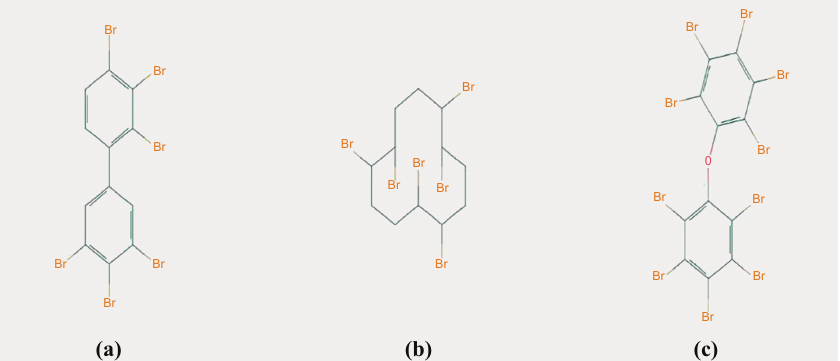
Figure 1. Chemical structures